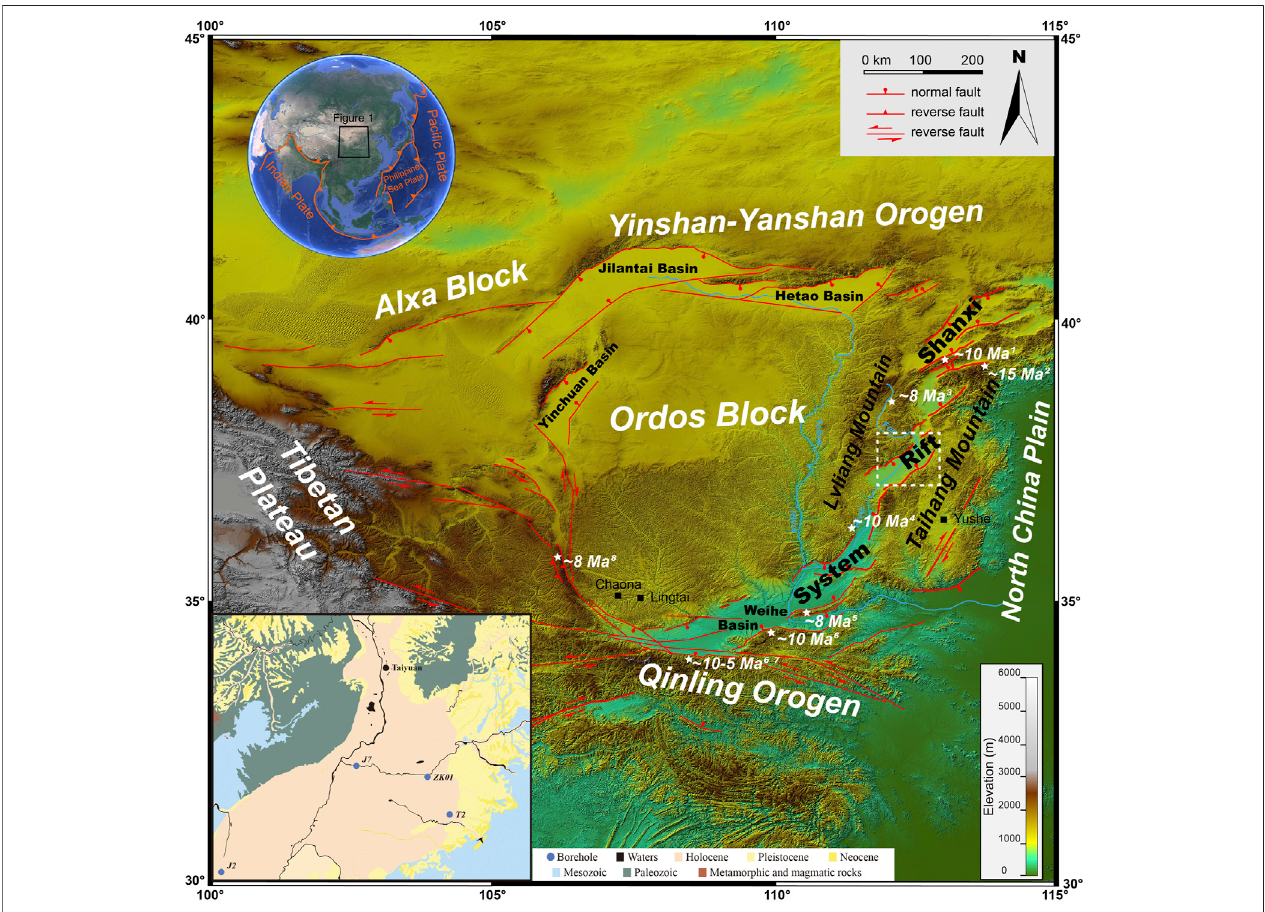
FIGURE1| Regionaltectonicsettinganddigitalelevation(SRTM90 mresolution)ofNorthChinaandadjacentregions.TheShanxiRiftSystemandtheotherbasin systems around the Ordos Block are mapped out. The white stars denote the published thermochronological data of rapid cooling events after late Miocene: (1) Clinkscales et al. (2020), (2) Qing et al.(2008), (3)Zhao et al. (2009), (4) Li Jianxing et al. (2015), (5) Su et al.(2021), (6)Liu et al. (2013), (7)Heberer et al. (2014), (8) Zheng et al. (2006). The dotted white box refers to the location of the Taiyuan Basin, and its stratigraphic map is shown at the bottom left corner (after Shanxi Bureau of Geology and Mineral Resources,